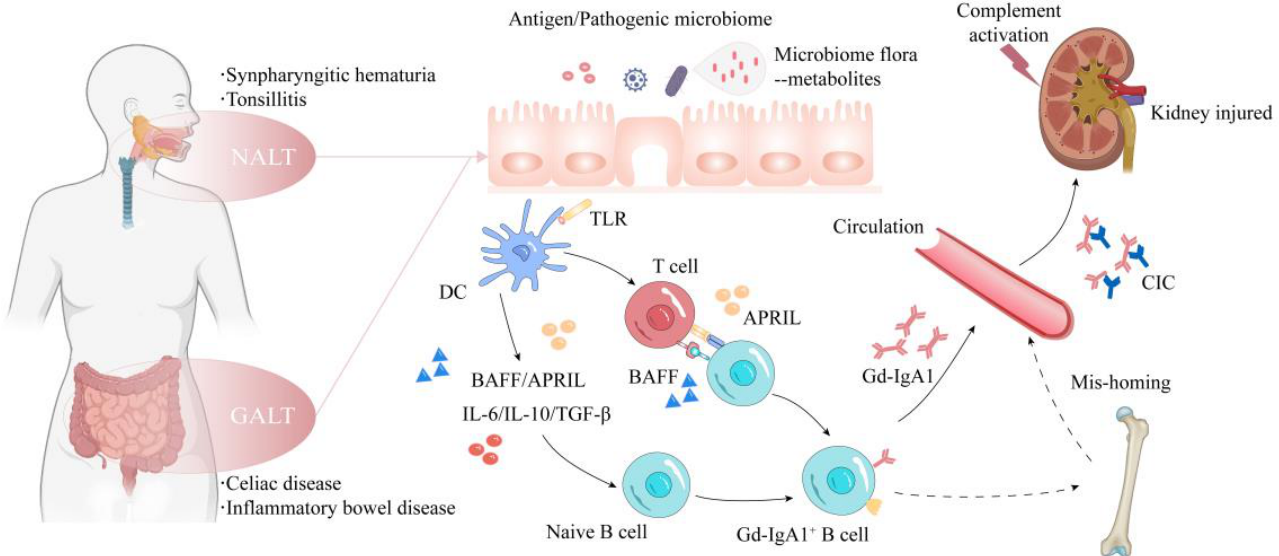
Figure 1. The pathophysiology of IgAN. IgAN usually presents with episodic gross hematuria and a concurrent upper respiratory tract infection or gastrointestinal disorder. Individuals with genetic susceptibility to IgAN develop aberrant mucosal immune responses to persistent antigenic stimulus, pathogenic microbiota and microbial metabolites. Antigen-presenting cells thereby activate and facilitate B-cells undergoing class switch and then differentiate into IgA+ ASCs in T-cell-dependent or T-cell-independent manners. Some mistrafficking ASCs take up residence in systemic sites, such as the bone marrow, NALT and GALT, leading to an increased circulating level of Gd-IgA1 and thus resulting in immune complex formation. The Gd-IgA1-containing immune complexes deposit in glomerular mesangium. Subsequently, complement activation (the alternative, lectin and terminal pathway) and intraglomerular inflammation together synergistically lead to kidney injuries, such as mesangial hypercellularity and fibrosis. ASC, antibody-secreting cell; CIC, circulating immune complex; DC, dendritic cell; NALT, nasal-associated lymphoid tissue; GALT, gut-associated lymphoid tissue; IgAN, IgA